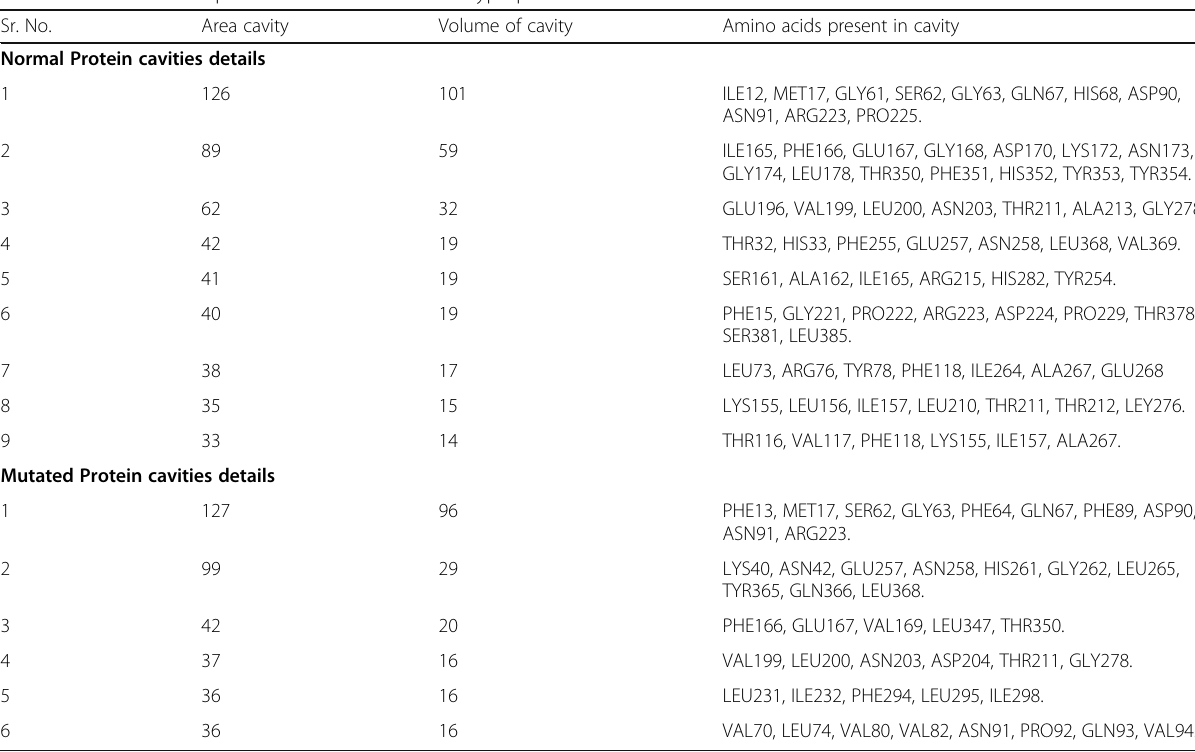
Table 2 Detailed description of cavities in the wild type protein Sr. No.